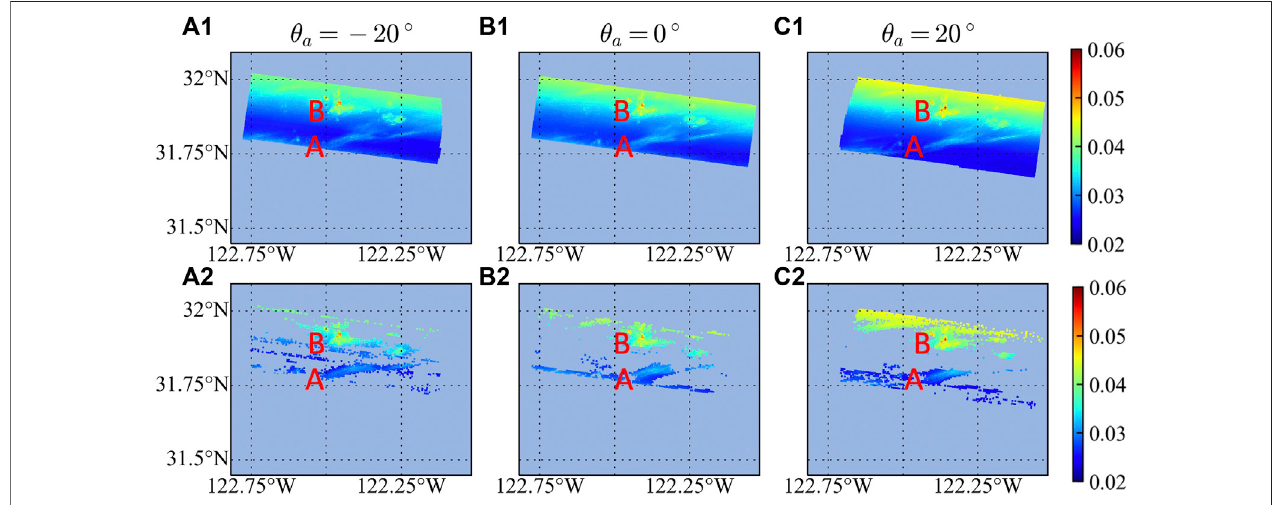
FIGURE 11 | Same as Figure 6 but for the re fl ectance for the red (670 nm) band after sunglint angles are removed (A1 – C1) , and the identi fi ed cloudy pixels by MAPDS (A2 – C2) . Two cloud patches are indicated by A and B. The linear feature may be due to an artifact from water condensation on the instrument lens.